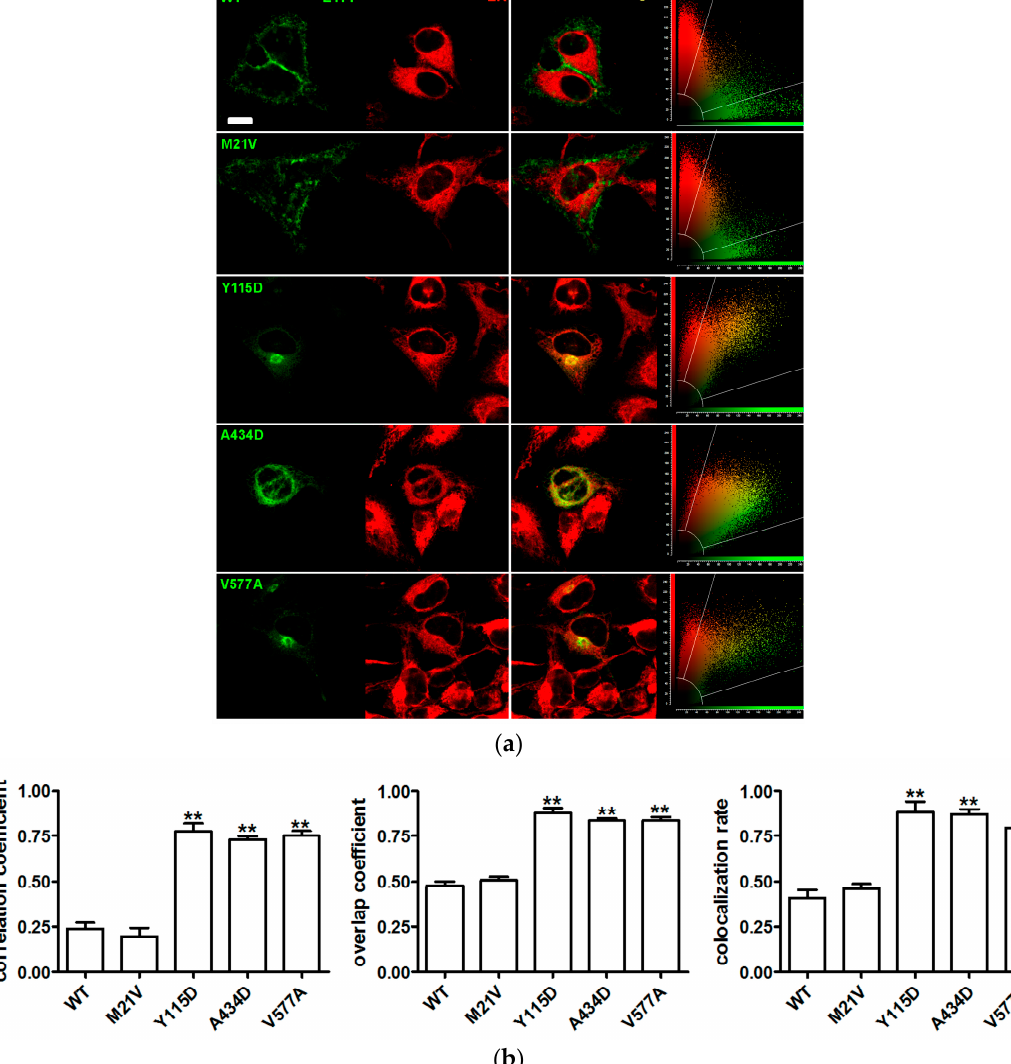
Figure 3. Co-localization of wild type pendrin and its variants with the endoplasmic reticulum (ER). ( a ) From left to right: fluorescent signal of EYFP (green) fused to the C-terminus of the indicated pendrin variants and ER (red) of living HeLa cells 72 h after transfection, corresponding merge image and scatter plot. Scale bar: 12 µm; ( b ) Pearson’s correlation coefficient, overlap coefficient and co-localization rate referred to the co-localization of wild type (WT) pendrin and the indicated variants with the ER. Error bars represent SEM. ** p < 0.01 compared to wild type and therefore retained within the ER, n = 12, one-way ANOVA with Dunnet’s multiple comparison post-test. ( n ) refers to the number of cells from 3 independent experiments.